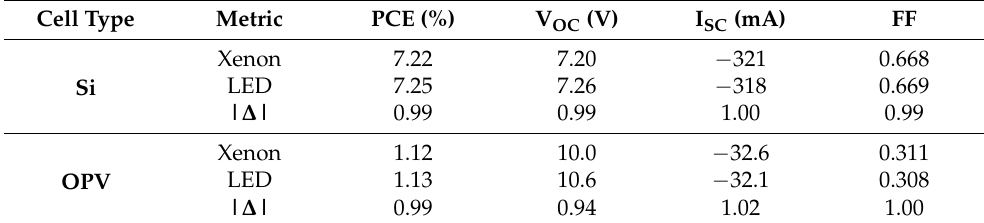
Table 5. Comparative values for Si and OPV cells under test.